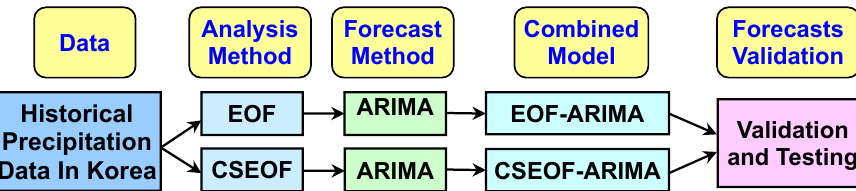
Figure 2. Scheme of the analysis and forecasting.